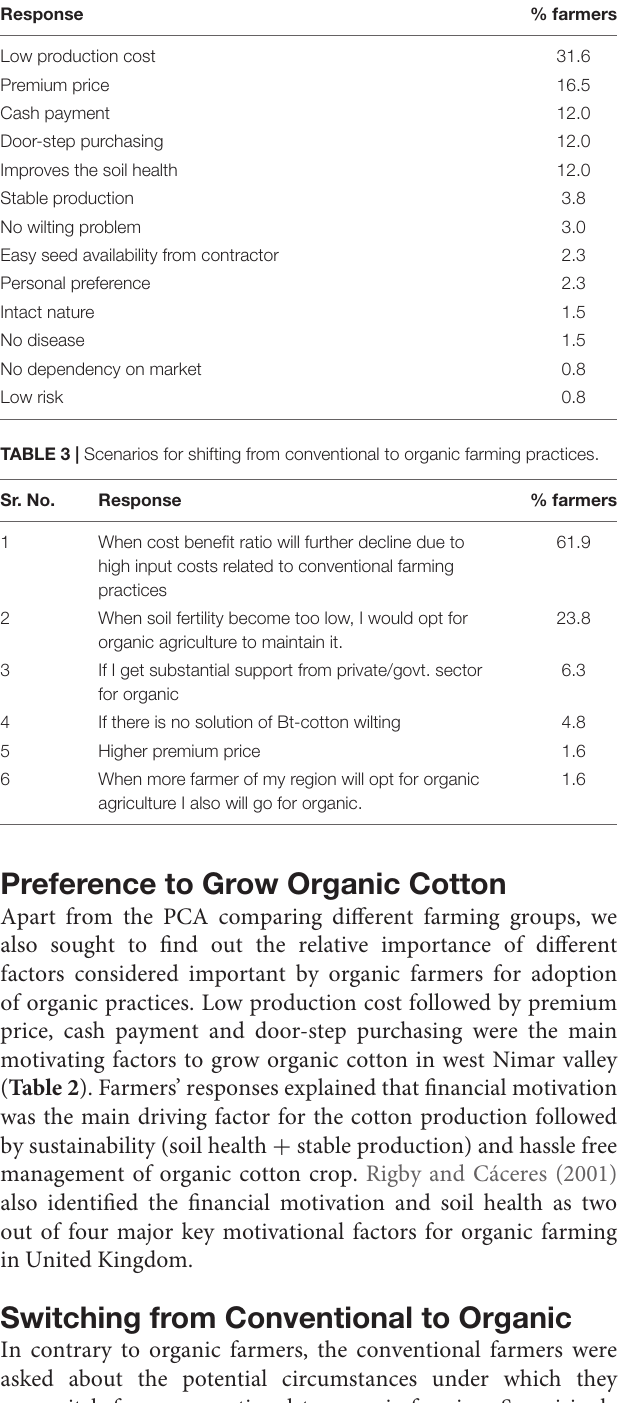
TABLE 2 | Main reasons of farmers to opt for organic cotton production and the proportion of farmers assigning importance to each. Response